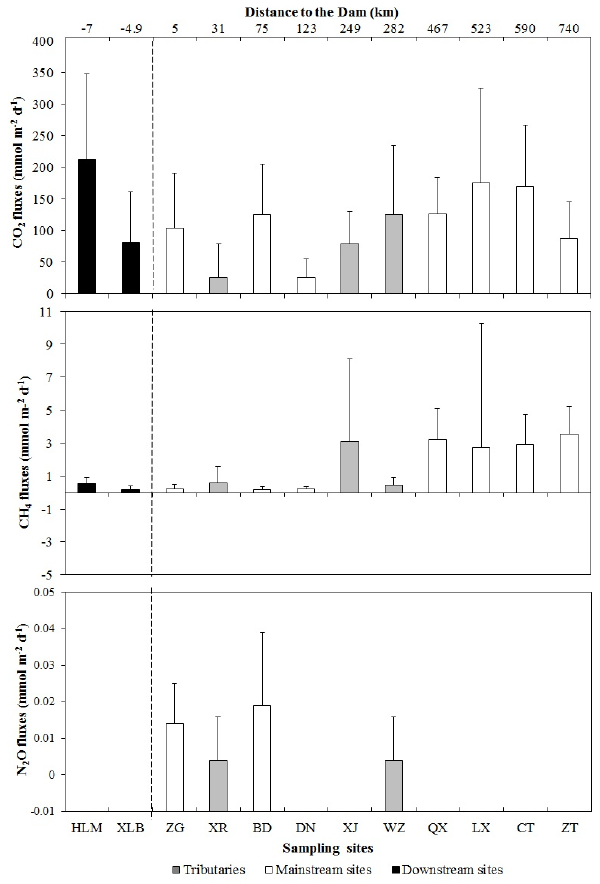
Fig. 2. Annual average GHG fluxes from different sampling sites of TGR. The dashed line demonstrates the location of the Three Gorges Dam. All the sampling sites are arranged according to their distance from the dam (labeled on the top x-axis). For the sampled tributaries (XR, DN and XJ), distance between the dam and tributary estuaries are used. Error bars indicated standard deviations with all the available replicates at each sites.